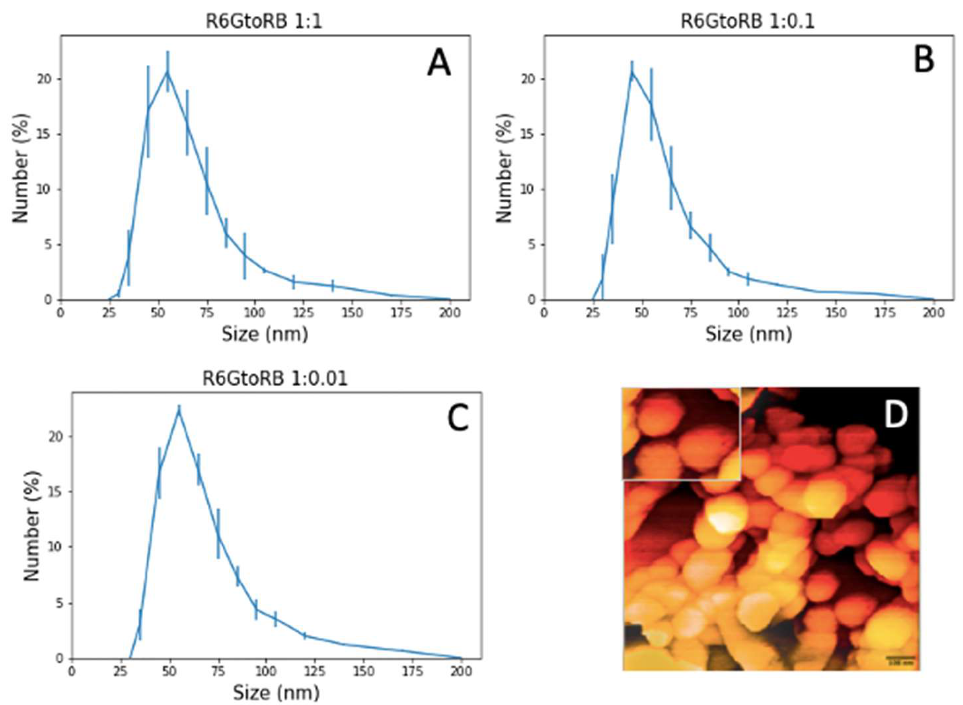
Figure 2. The results of dynamic light scattering (DLS) measurements of the particle size distribution at three different ratios of R6G to RB, including 1:1, 1:0.1, and 1:0.01, ( A – C ), respectively. ( D ) AFM image of nanoparticles with the scale bar of 100 (nm). A 500 × 350 nm insert clearly demonstrates the particle